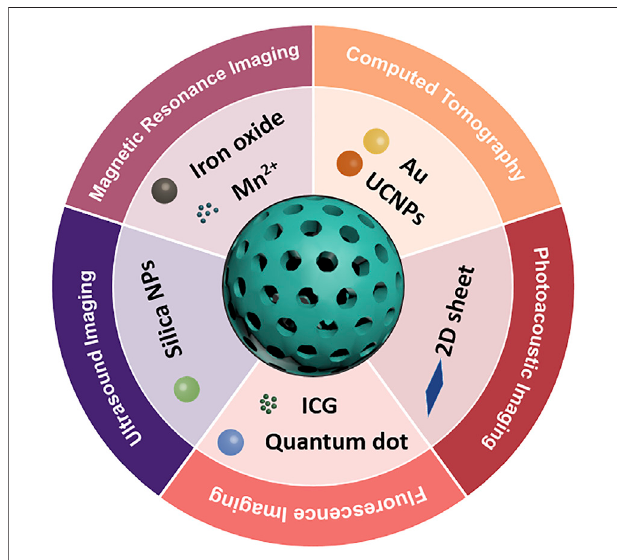
FIGURE 1 | Different imaging modalities based on